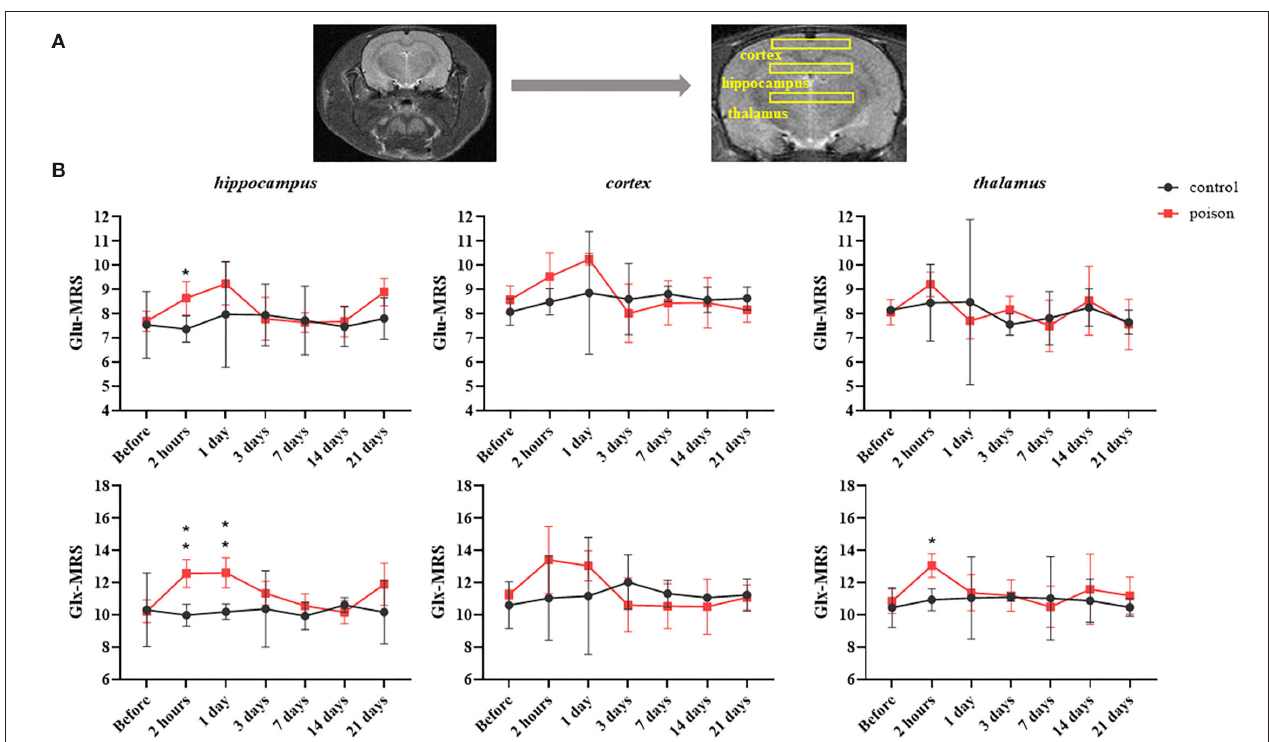
FIGURE 5 | Regions of interest in the T 2 WI for 1 H-MRS (A) and regional data (B) from 1 H-MRS at different time points before and after CO exposure. * p < 0.05, ** p < 0.01.